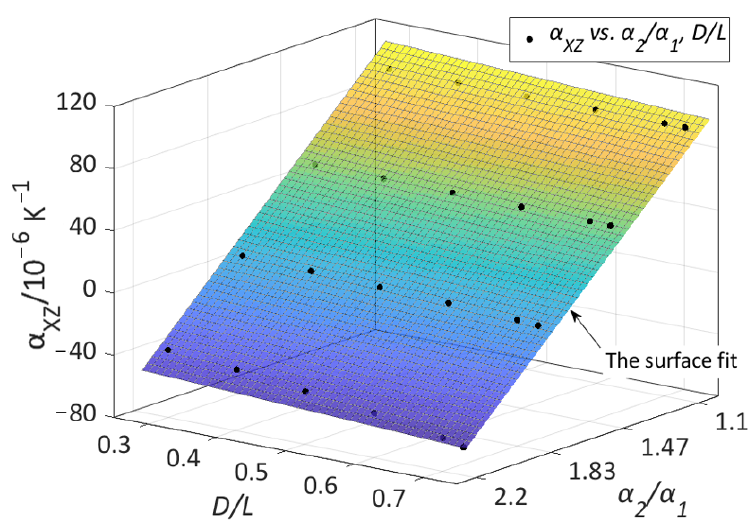
Figure 9. The low planar CTE lattice results and its surface fit, where L is the original length of the lattice and D is the original diameter of the cylindrical inner part, and α 2 / α 1 is the ratio of CTEs of the cylindrical inner part material and the lattice outer part material.